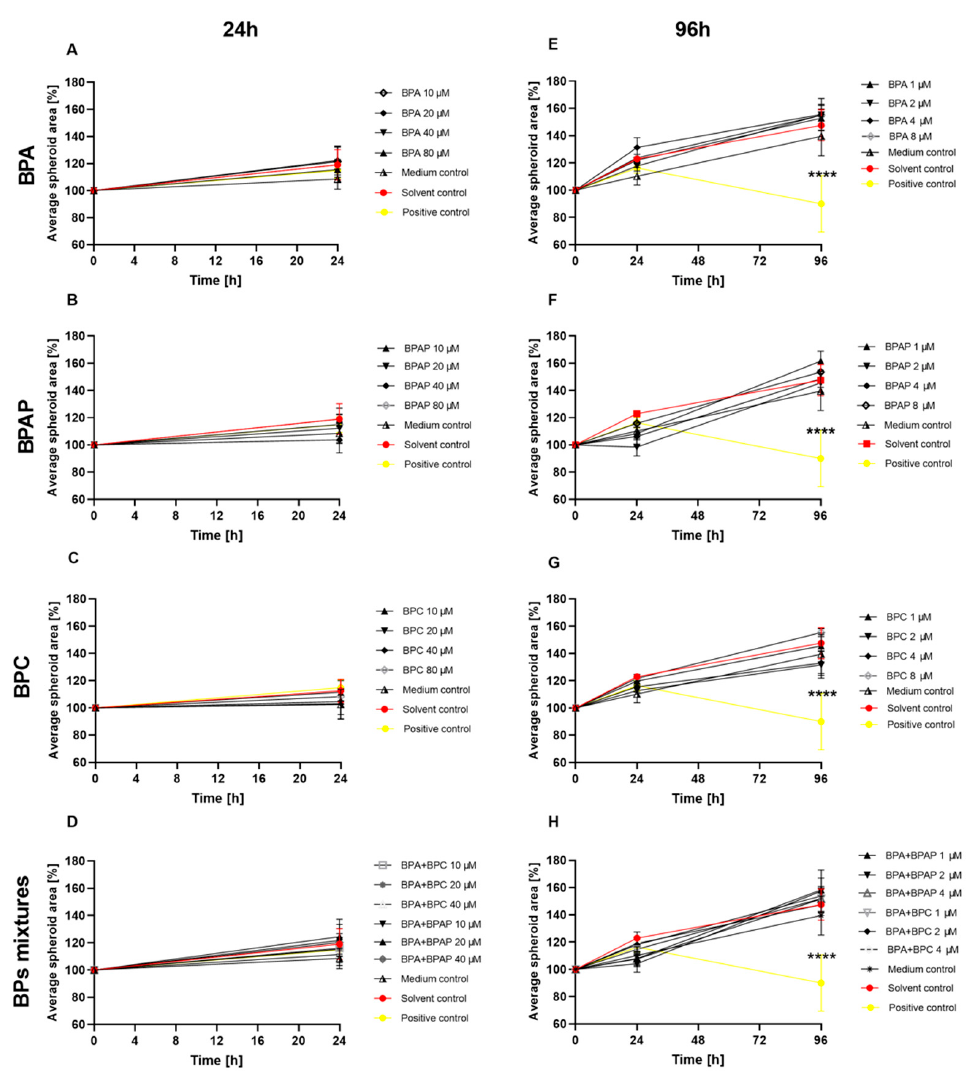
Figure 3. Planimetry measurements of spheroids (3-day old) before treatment (0) and after 24 and 96-h treatment with BPA, BPAP, BPC ( A – C , E – G ) and their binary mixtures ( D , H ). ( A – D ) Figures show the change in % of the average spheroid area after 24 h of exposure compared to the average area at the beginning of treatment. ( E – H ) Figures show the change in % of the average spheroid area after 24 h and 96 h of exposure compared to the average area of the 72-h old spheroid. The growth of spheroids was monitored at 4 × magnification. 15% DMSO served as a positive control (PC). Results are presented as mean ± SD (N = 10) of three biologically independent experiments. * different from solvent control, **** p < 0.0001 (one-way ANOVA; Dunnett’s multiple comparison test).